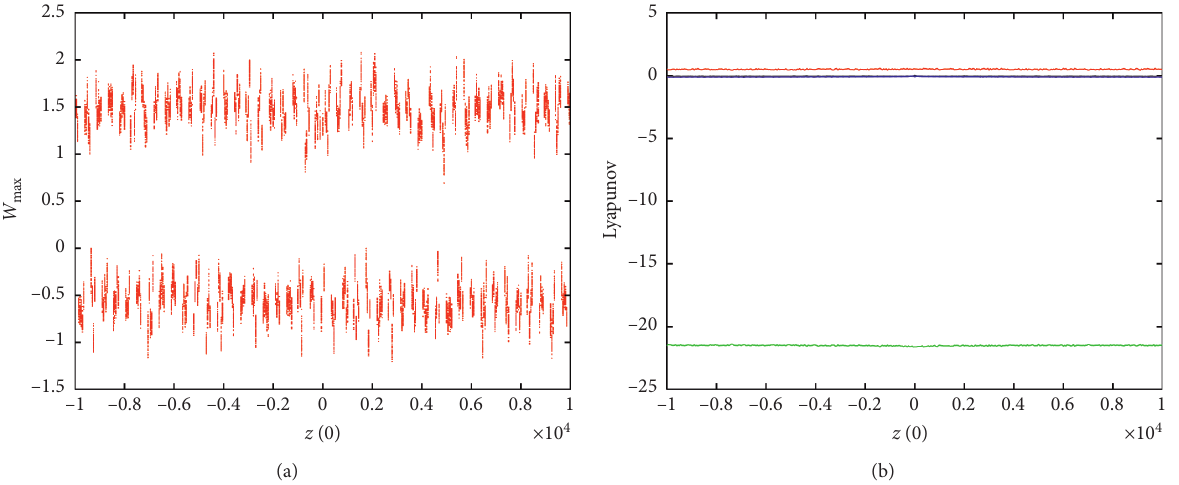
Figure 11: (a) Bifurcation diagram of the state variable w and (b) Lyapunov spectrum with respect to initial condition z ( 0 ) in the region [− 10 4 , 10 4 ]